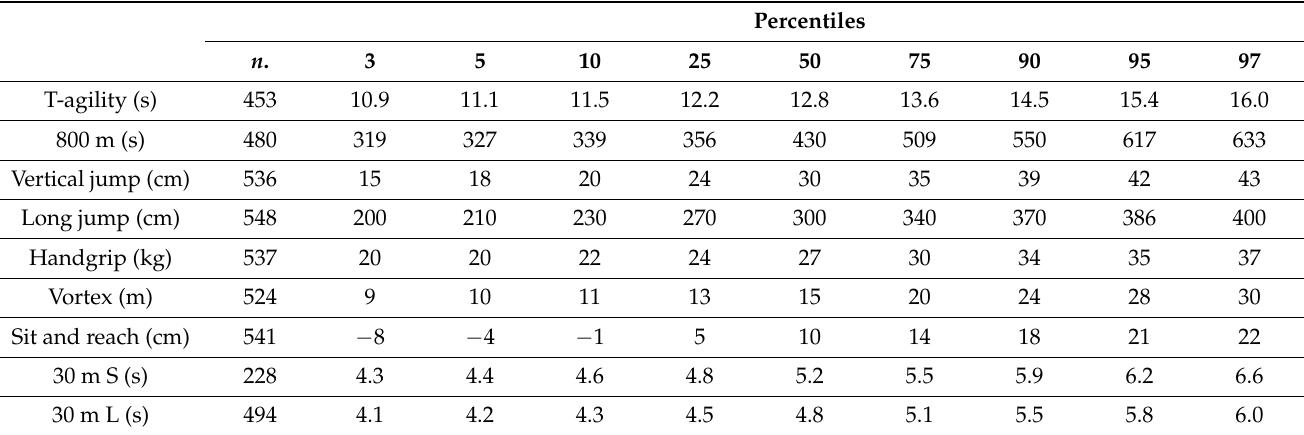
Table 3. Fitness test percentiles for females in the first class of the high school.